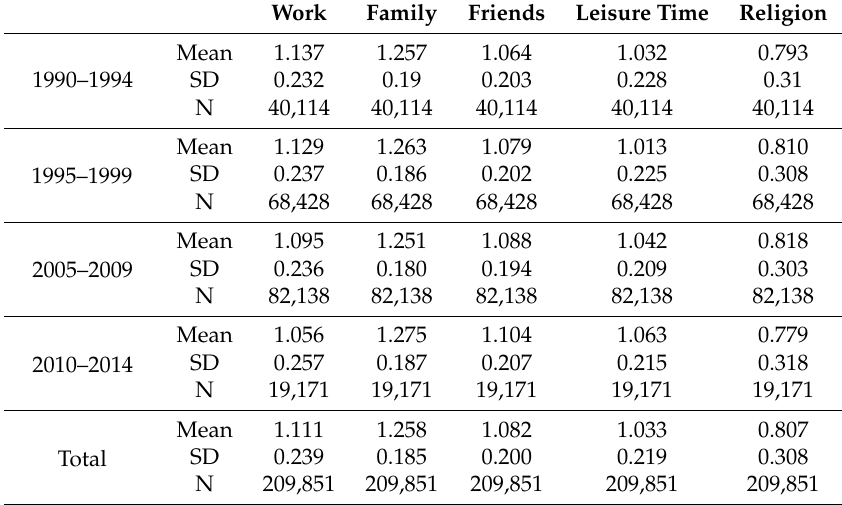
Table 1. Number of observations and the average of relative importance of life aspects by